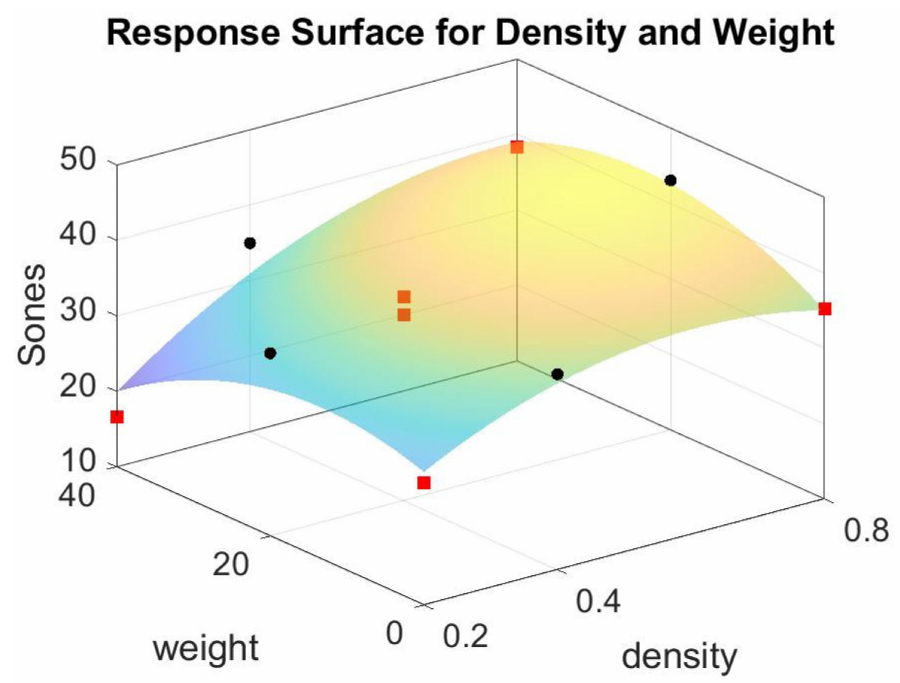
Figure 10. The response surface for ten data points in Table